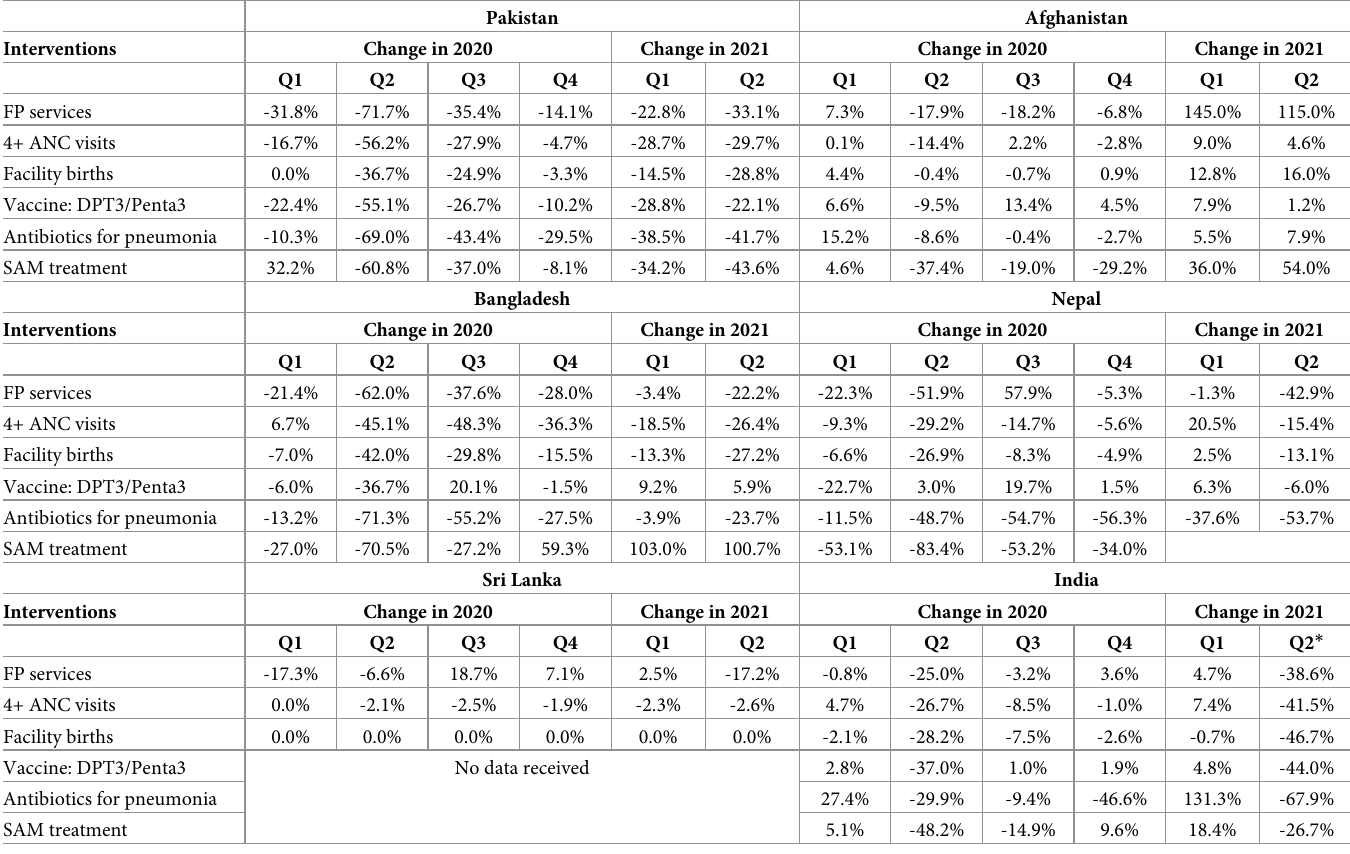
Table 1. Observed coverage disruption of selected SRMNCH services due to the COVID-19 pandemic in South Asia, Jan 2020 to Jun 2021. Interventions